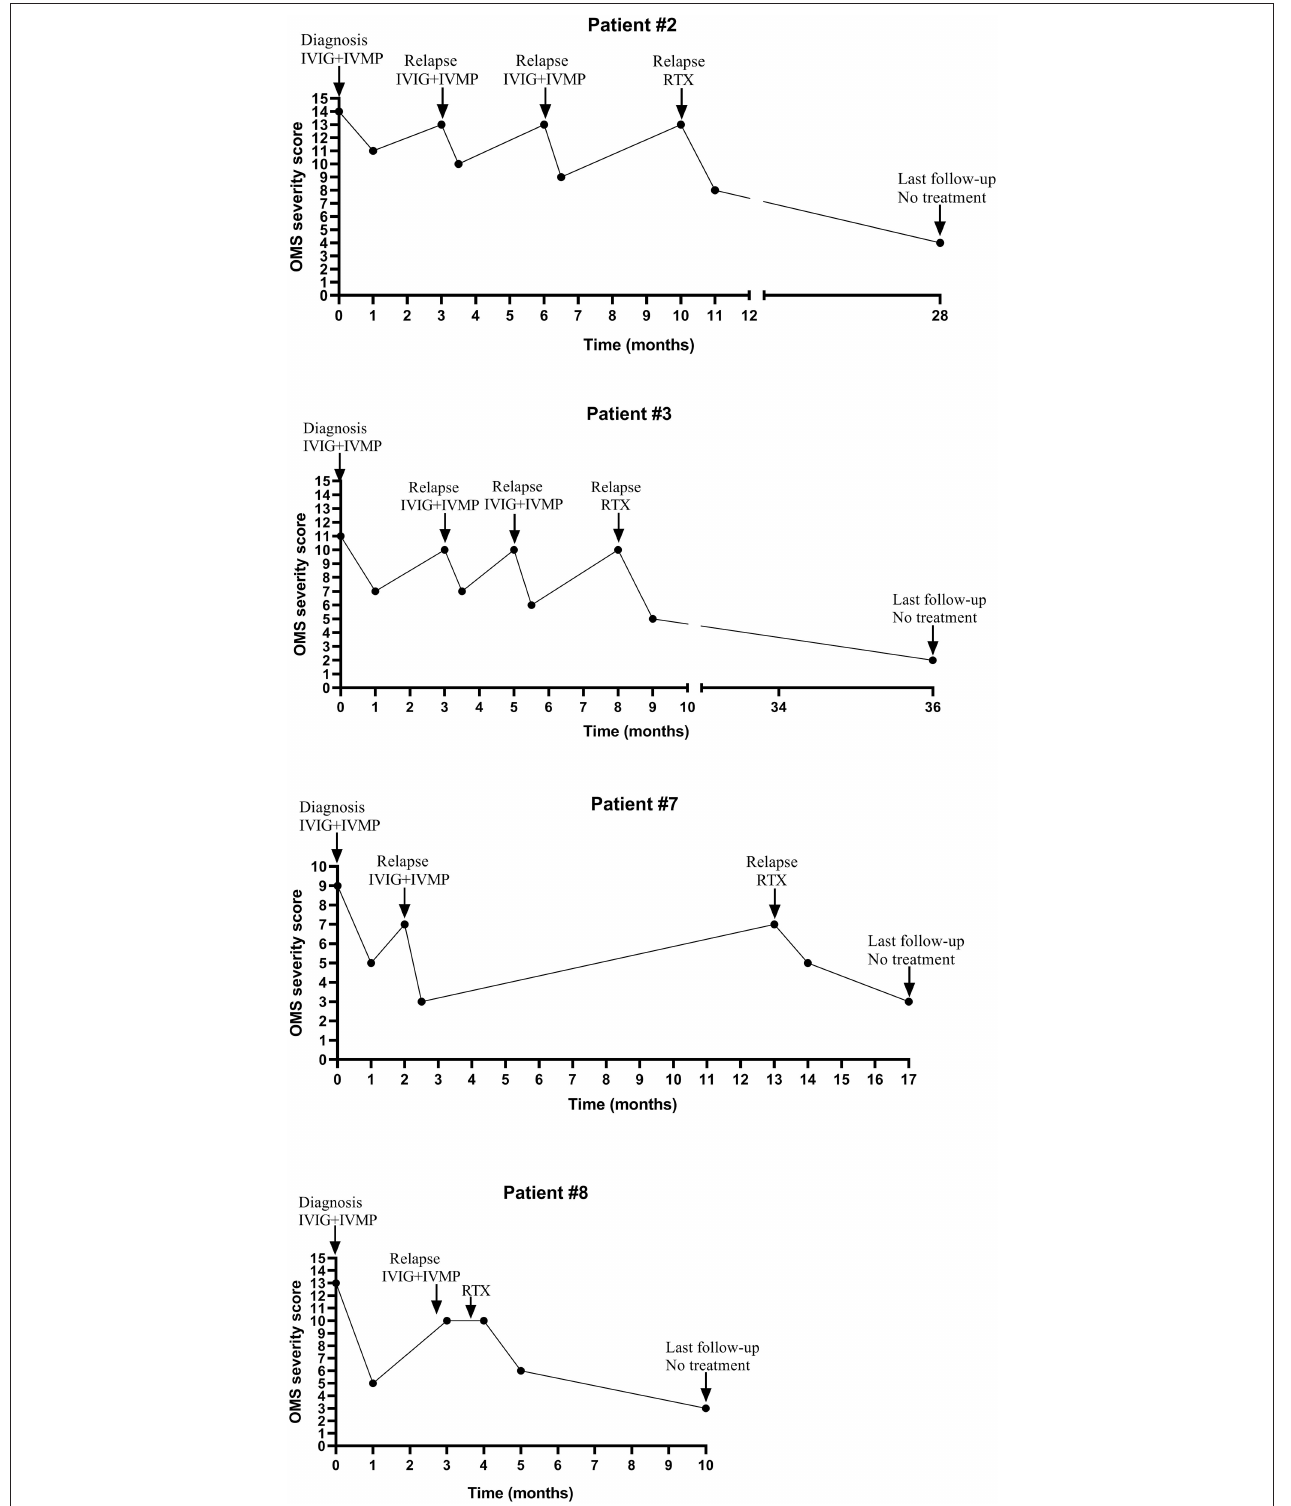
FIGURE 2 | The change of OMS severity score and immunotherapy of four relapsed patients during the clinical course.